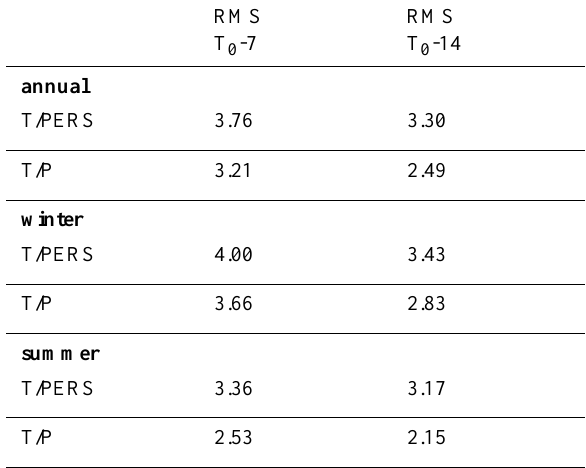
Table 1. RMS of the differences between NRT and delayed time altimeter maps. The column with RMS at T 0 -7 days corresponds to the actual NRT MFSPP system. The column at T 0 -14 days stresses the problem of the shift in the observation period